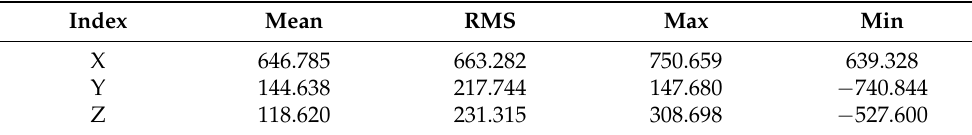
Figure 12. Initial positioning residuals distribution of TH-1 HR camera. ( a ) Positioning residuals in XY planar direction; ( b ) Positioning residuals in the elevation direction. Table 9. Initial positioning accuracy of TH-1 HR camera. (Unit: